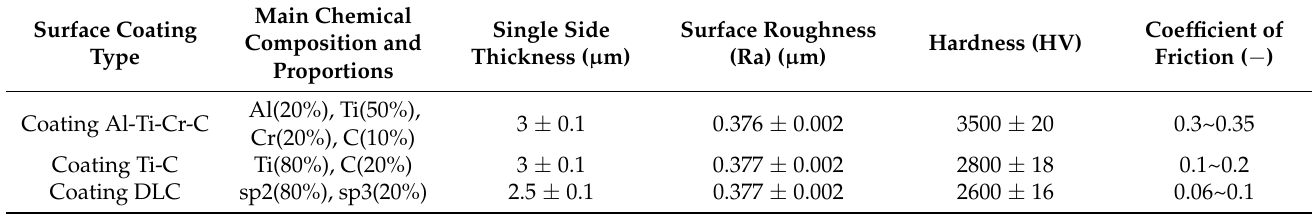
Table 2. Types of coatings and their mechanical and tribological properties.